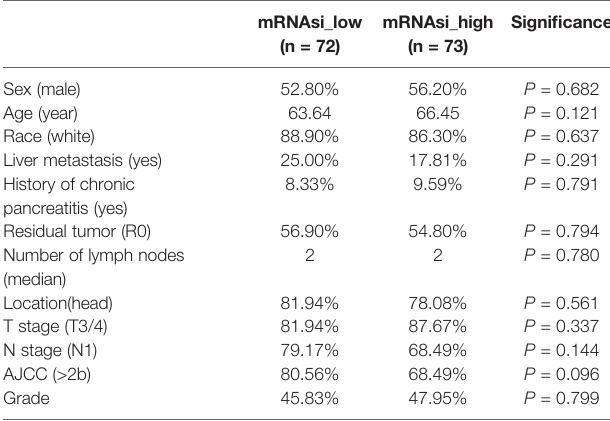
TABLE 1 | Basic characteristics of patients with different mRNAsi